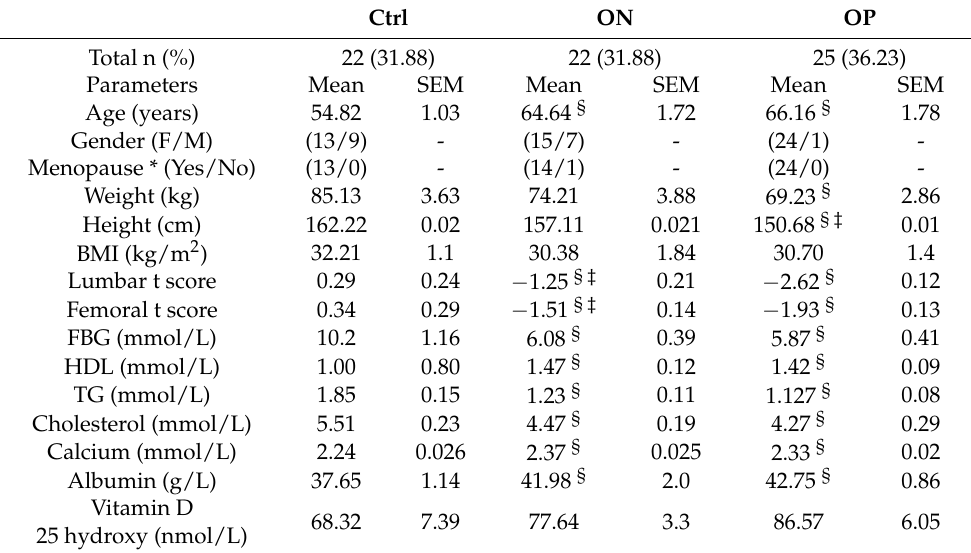
Table 1. Clinical characteristics and demographics of the study population (n =